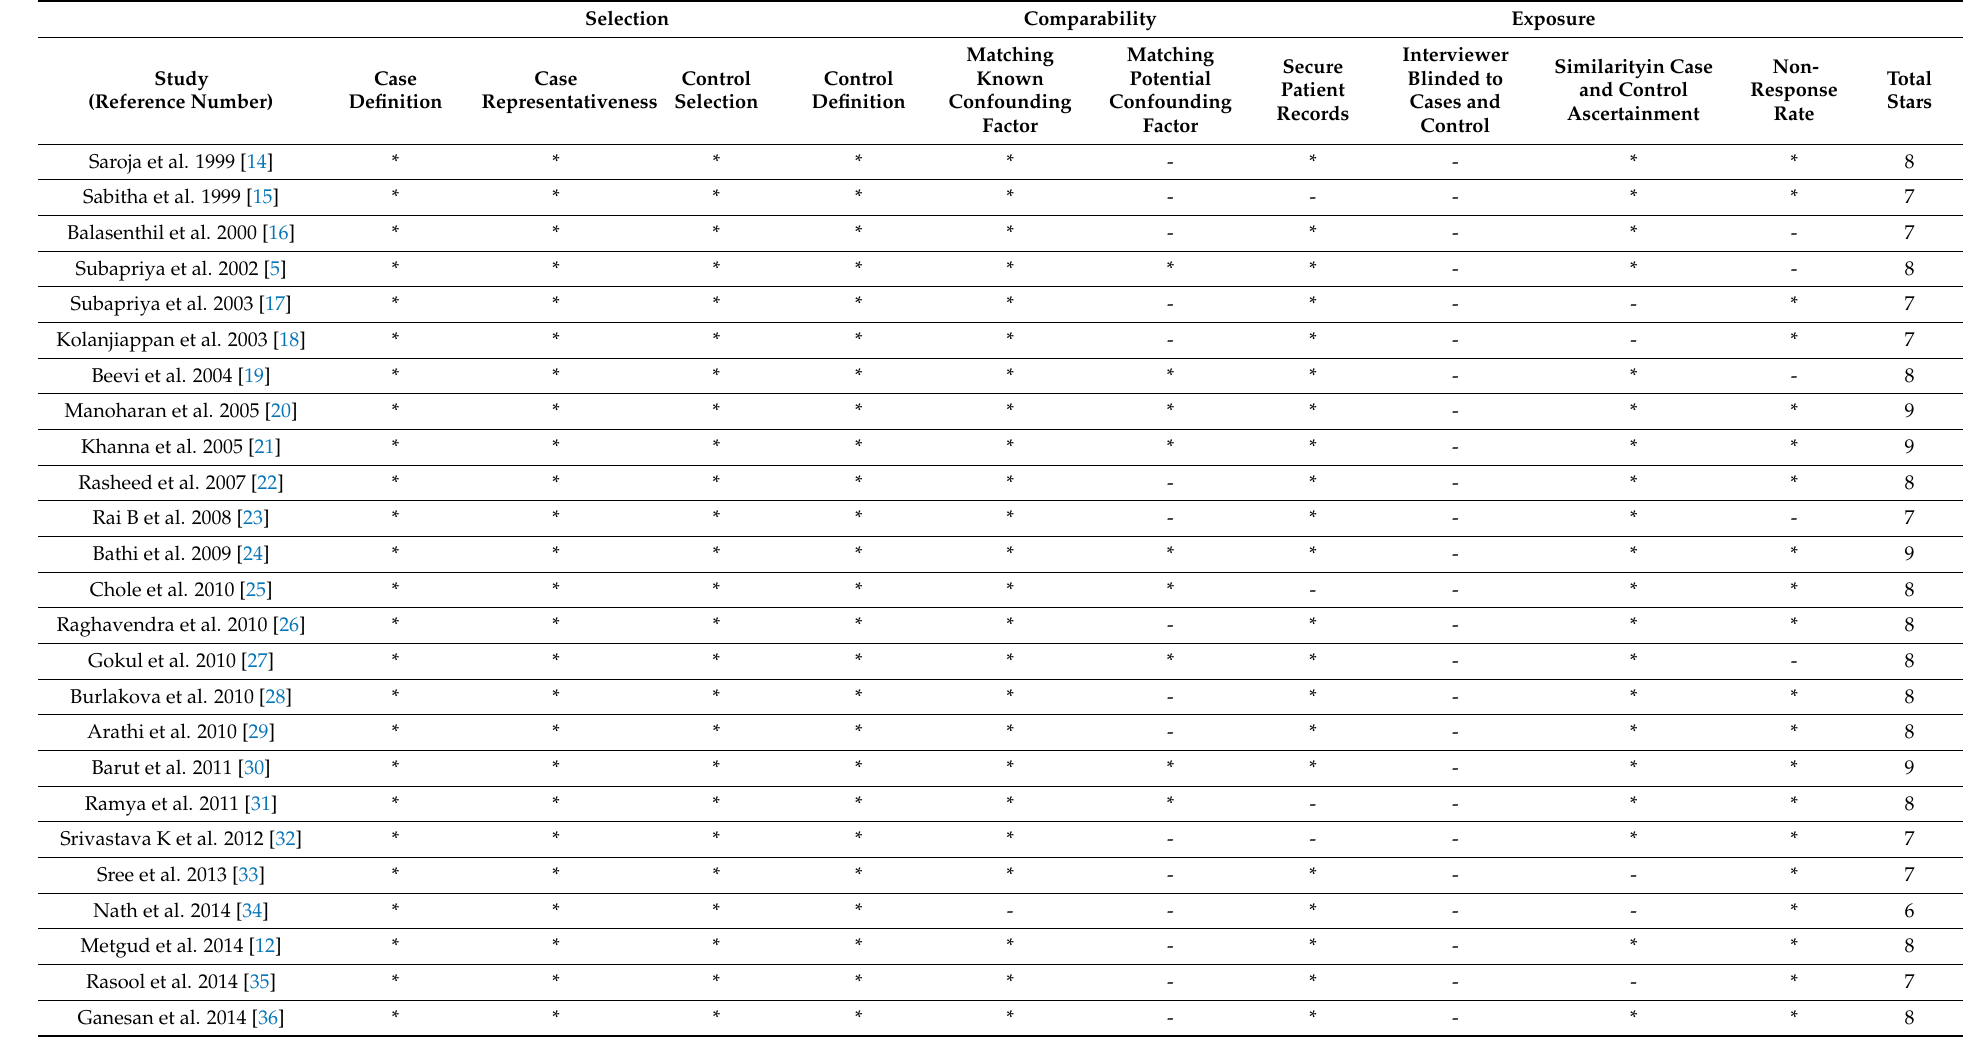
Table 1. New Castle Ottawa Scale for studies included in the Systematic